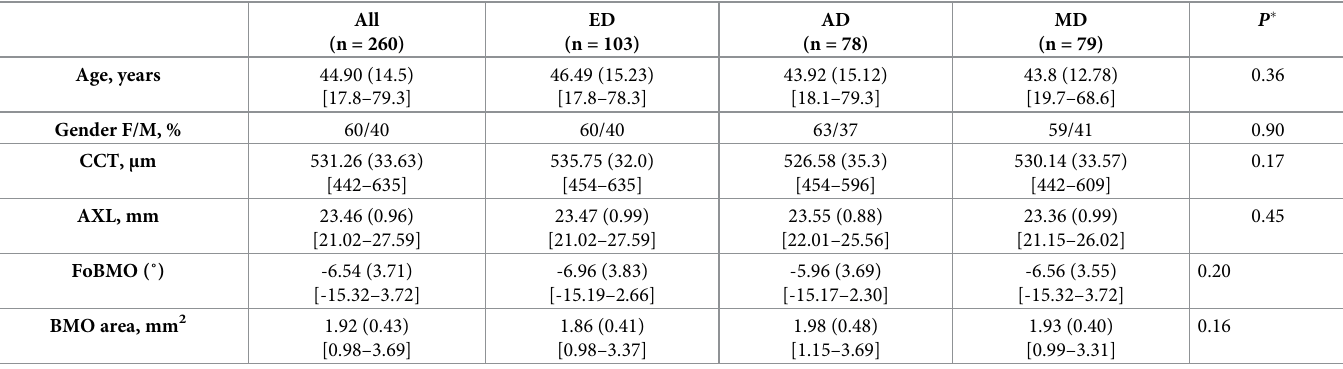
Table 1. Clinical characteristics of study subjects.